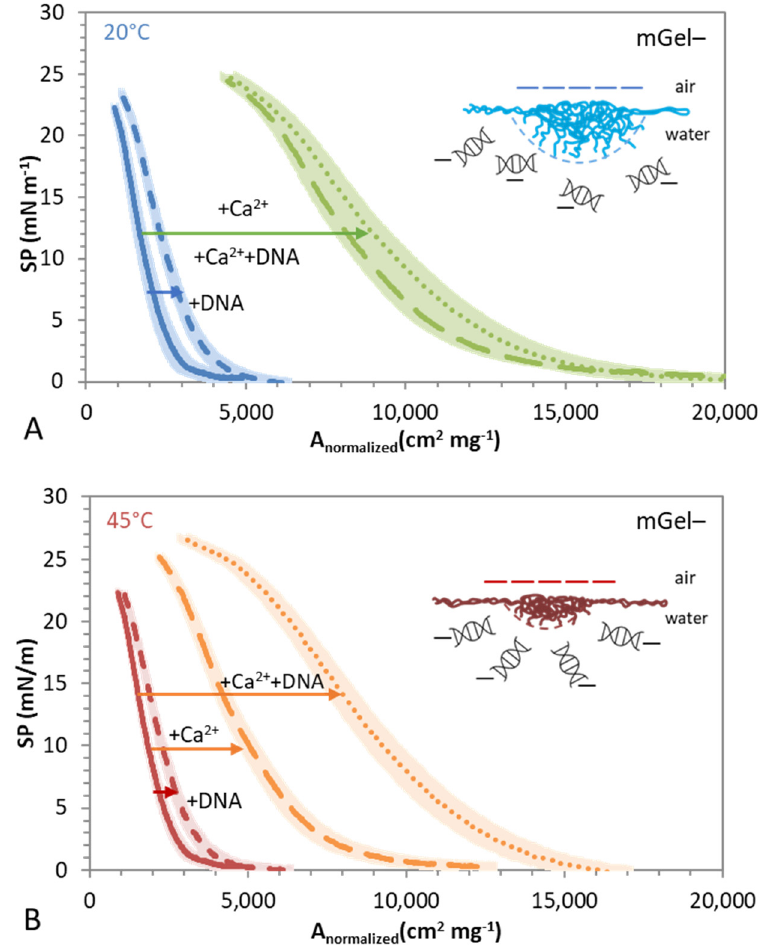
Figure 6. Compression isotherms obtained for swollen mGel − spread on different subphases: water (solid lines), DNA (short dash), Ca(NO 3 ) 2 (long dash), and DNA+Ca(NO 3 ) 2 (dot) . [DNA] = 0.025 gL − 1 , [Ca(NO 3 ) 2 ] = 1 mM. ( A ) Swollen microgels, 20 °C. ( B ) Shrunken microgels, 45 °C. Values plotted are the mean of three independent measurements with standard deviation in lighter color. Schematic diagram of the surface interaction between DNA/mGel − mediated by Ca 2+ . DNA illustration is not to scale.